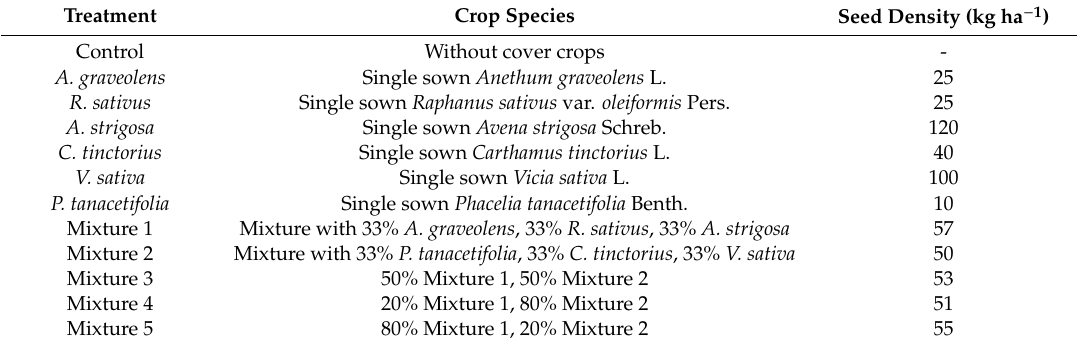
Table 2. Twelve treatments including an untreated control treatment without cover crops, six single sown cover crops and five cover crop